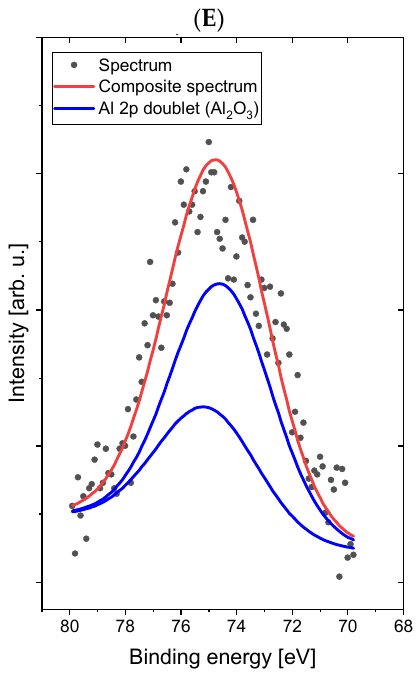
Figure 4. High-resolution XPS spectra of Sample 1 (without addition of dextrin) in the areas C 1s/K